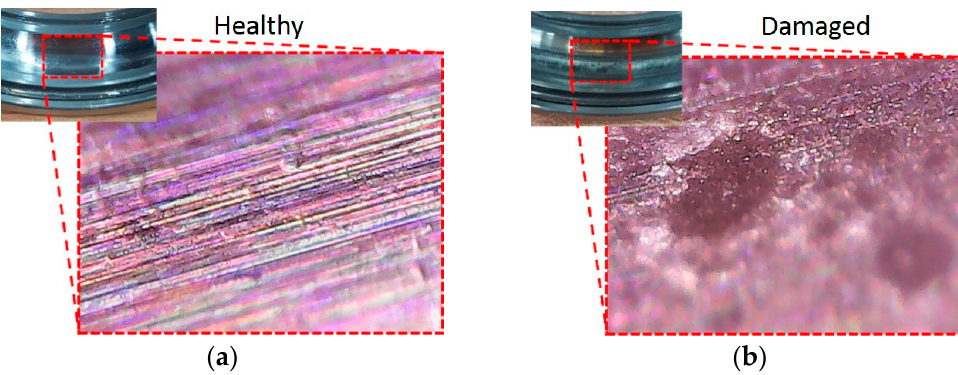
Figure 7. Microscopic view of the bearing: ( a ) healthy bearing; ( b ) damaged bearing.